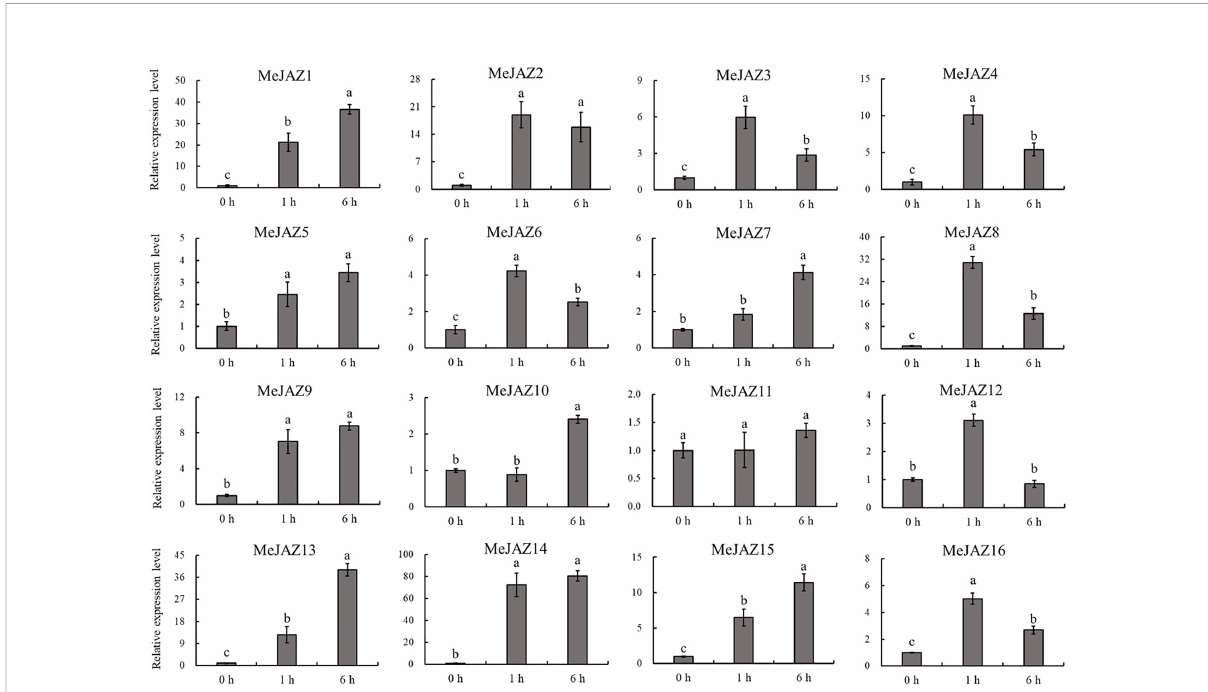
FIGURE 7 Expression pro fi les of 16 JAZ genes under exogenous JA treatment in cassava as determined by qRT-PCR. The error bars represent the standard error of the means of three independent replicates. Values denoted by the same letter did not differ signi fi cantly at P < 0.05 according to Duncan's multiple range